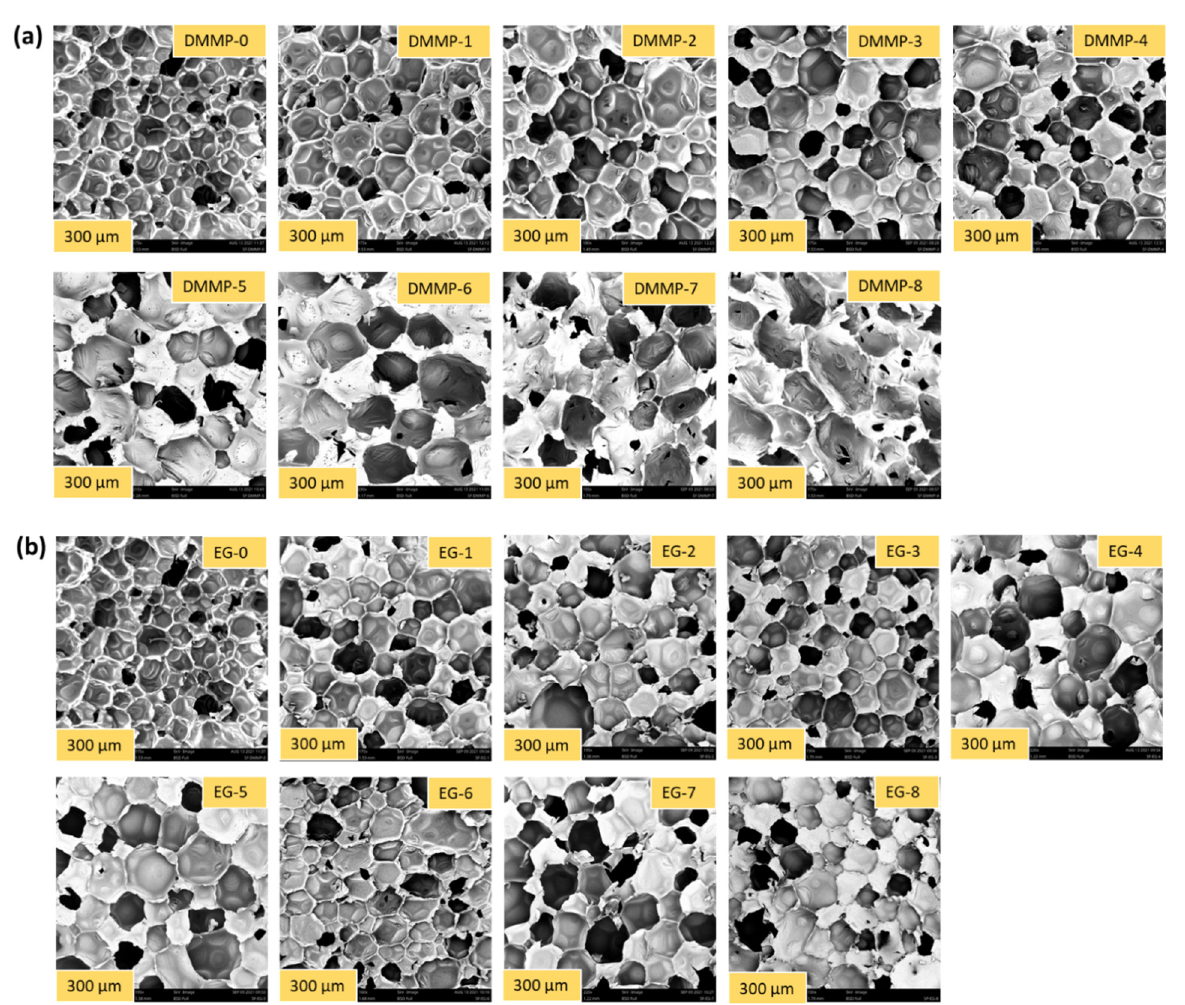
Figure 3. SEM micrographs for the foams with increasing concentrations of ( a ) DMMP and ( b ) EG.